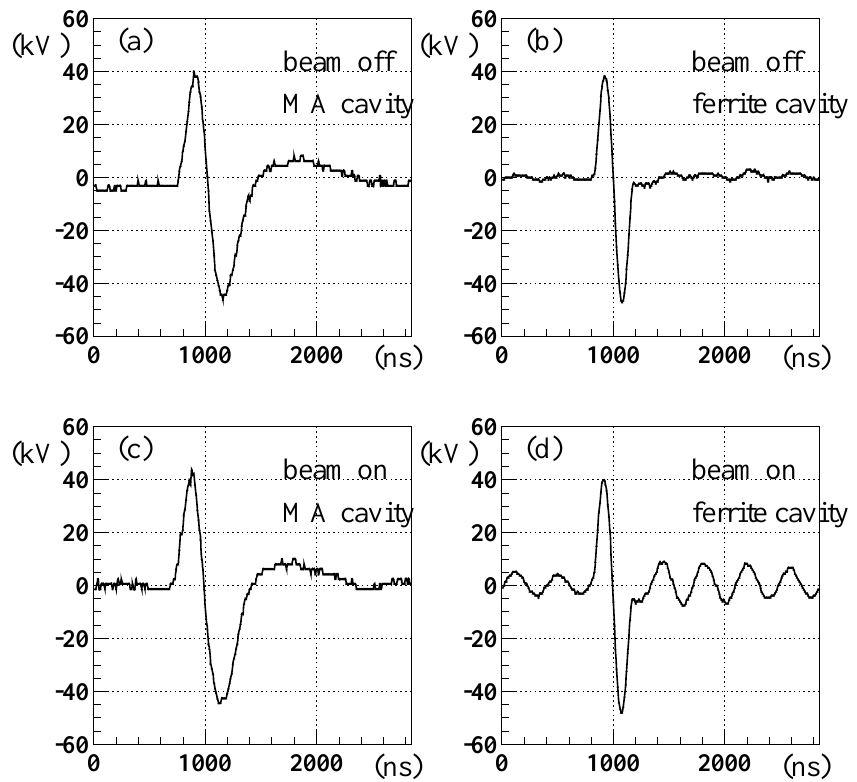
FIG. 14. Gap voltages: (a),(c) MA cavity; (b),(d) ferrite cavity. (a),(b) without beam, (c),(d) with beam. The horizontal and vertical coordinates are time and voltage per gap, respectively. The beam loading of the MA cavity was compensated by feed forward. The beam intensity was 8.7 3 10 12 protons (cid:1) bunch.